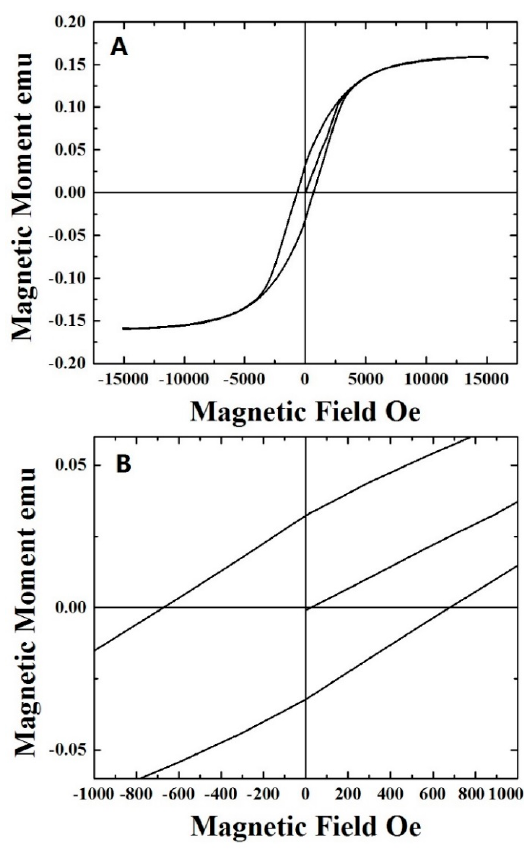
Figure 5. Room temperature magnetization versus field curves of the as grown CNTs buckypaper. ( A ) shows the typical ferromagnetic hysteresis loop of the sample; (B ) shows the measured coercivity.